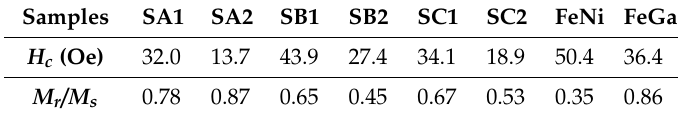
Figure 3. Hysteresis loops of SA1, SA2, SB1, SB2, SC1, SC2, FeNi (500 s), and FeGa (500 s). The comparison of loops for SA1 and SA2 ( a ), SB1 and SB2 ( b ), SC1 and SC2 ( c ). The loops of FeNi on top layer ( d ). The loops of FeGa on top layer ( e ). The loops of single FeNi and FeGa ( f ). Table 2. H c and M r / M s of SA1, SA2, SB1, SB2, SC1, SC2, FeNi (500 s), and FeGa (500 s).